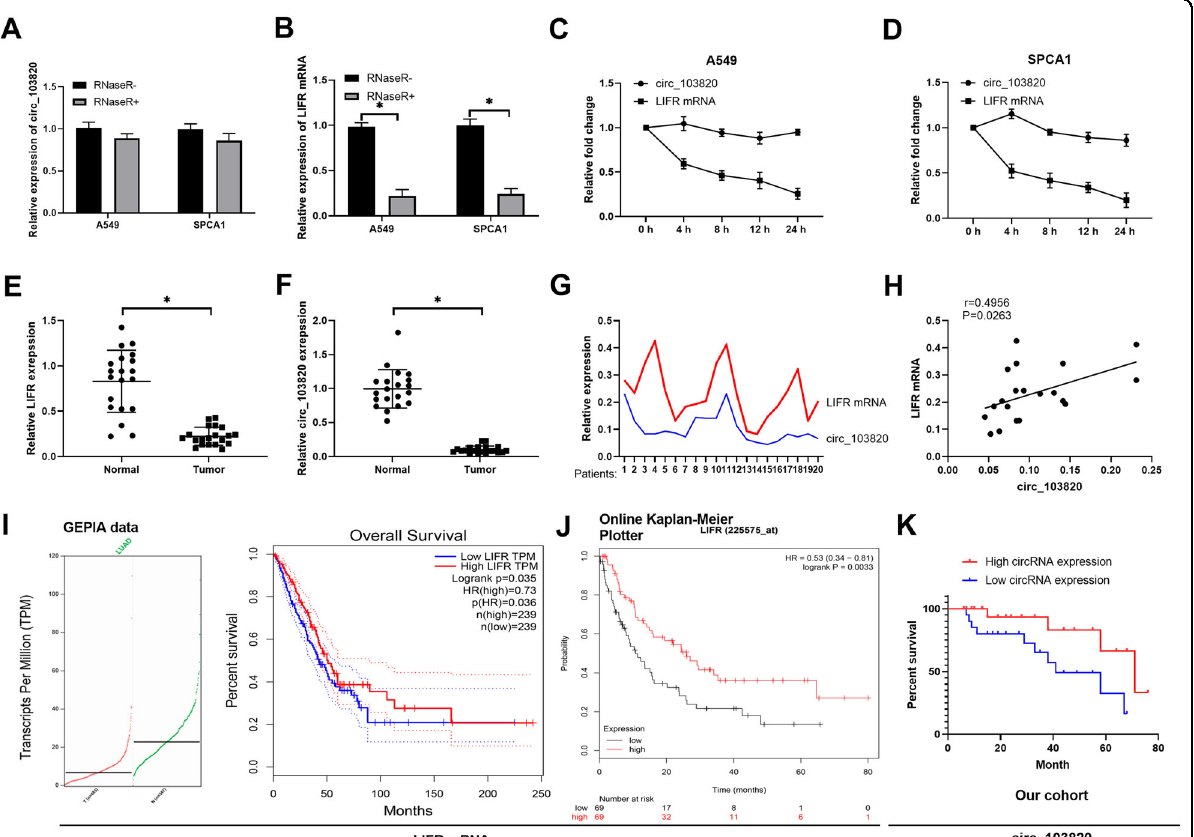
Fig. 2 High expression of LIFR and hsa_circ_103820 was related to a relatively good prognosis in lung cancer. A, B After treatment with RNase R, hsa_circ_103820 and LIFR mRNA expression was con fi rmed by qRT-PCR assay in A549 and SPCA1 cells. qRT-PCR was utilized to determine the resistance of hsa_circ_103820 to actinomycin in A549 ( C ) and SPCA1 cells ( D ). The expression of LIFR ( E ) and hsa_circ_103820 ( F ) was examined using qRT-PCR analysis in paracarcinoma tissues ( n = 20) and lung cancer tissues ( n = 20). G The relative LIFR and hsa_circ_103820 expression levels are displayed in 20 patients, and the trend is shown in the line chart. H Correlation analysis was applied to certify the relevance between LIFR and hsa_circ_103820 in lung cancer ( r = 0.4956, P = 0.0263). The prognosis of LIFR was analyzed using GEPIA data ( I ) and Kaplan-Meier Plotter ( J ). K The survival curve of hsa_circ_103820 was estimated in our lung cancer cohort. Data are mean ± SD, n = 3. * P < 0.05 (Student ’ s t